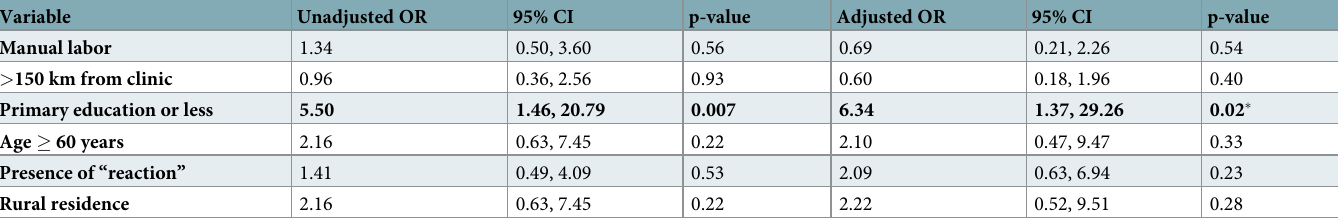
Table 3. Unadjusted and adjusted odds ratio of factors associated with disability (Grade 1 or 2) left in the final model. Bolded values are significant at an alpha of < 0.05. � Defined as either Type 1 or Type 2 leprosy reaction. Variable Unadjusted OR 95% CI